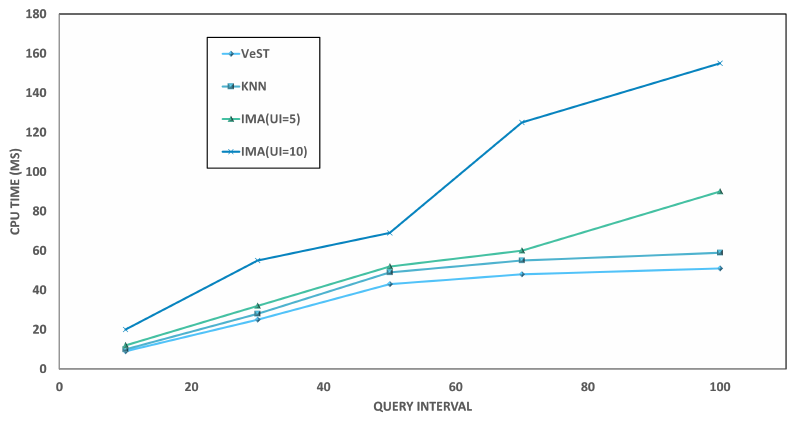
Figure 10. Effect of query interval length on CPU